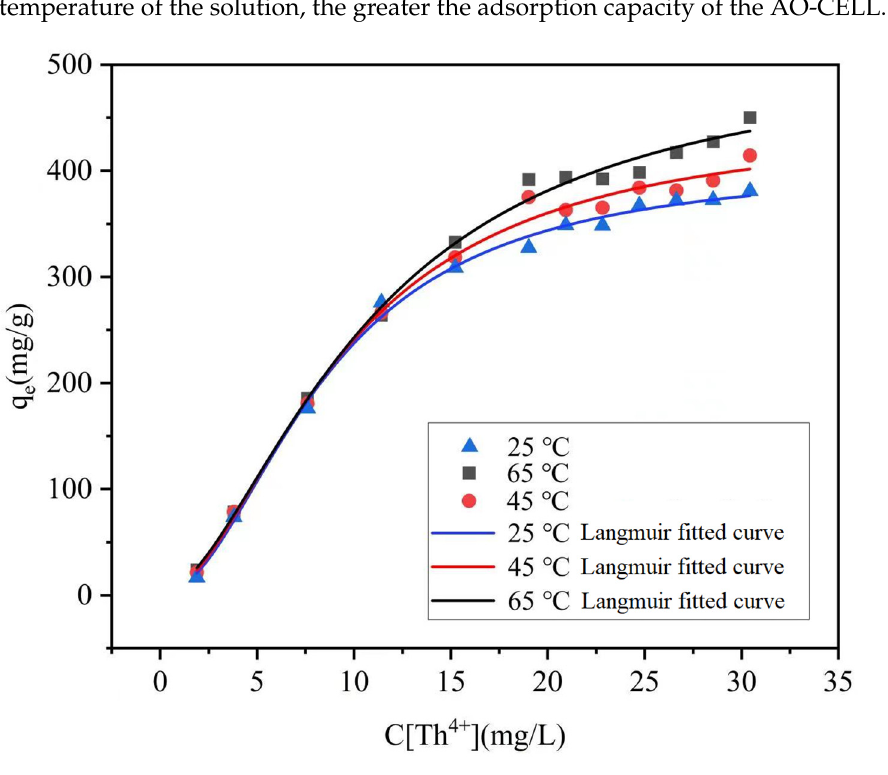
Figure 9. Effect of the initial concentration of Th(IV) and the temperature of the solution to the ad- adsorption process. (Experiment conditions: temperature = 25.00 ◦ C (9a)/45.00 ◦ C (9b)/65.00 ◦ C (9c); sorption process. (Experiment conditions: temperature = 25.00 °C (9a)/45.00 °C (9b)/65.00 °C (9c); C 0 [Th(IV)] = 3.80~30.40 mg/L; solid/liquid ratio = 0.032 g/L; pH = 3.00 ± 0.05; t = 0.5 C 0 [Th(IV)] = 3.80 ~ 30.40 mg/L; solid/liquid ratio = 0.032 g/L; pH = 3.00 ± 0.05; t = 0.5 h.)